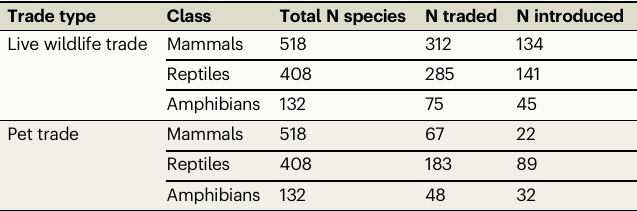
Table 1 | Sample sizes for